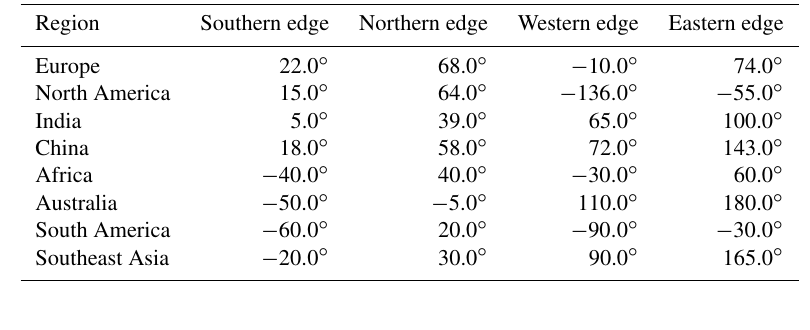
Table F1. Summary of regions mentioned in the results.